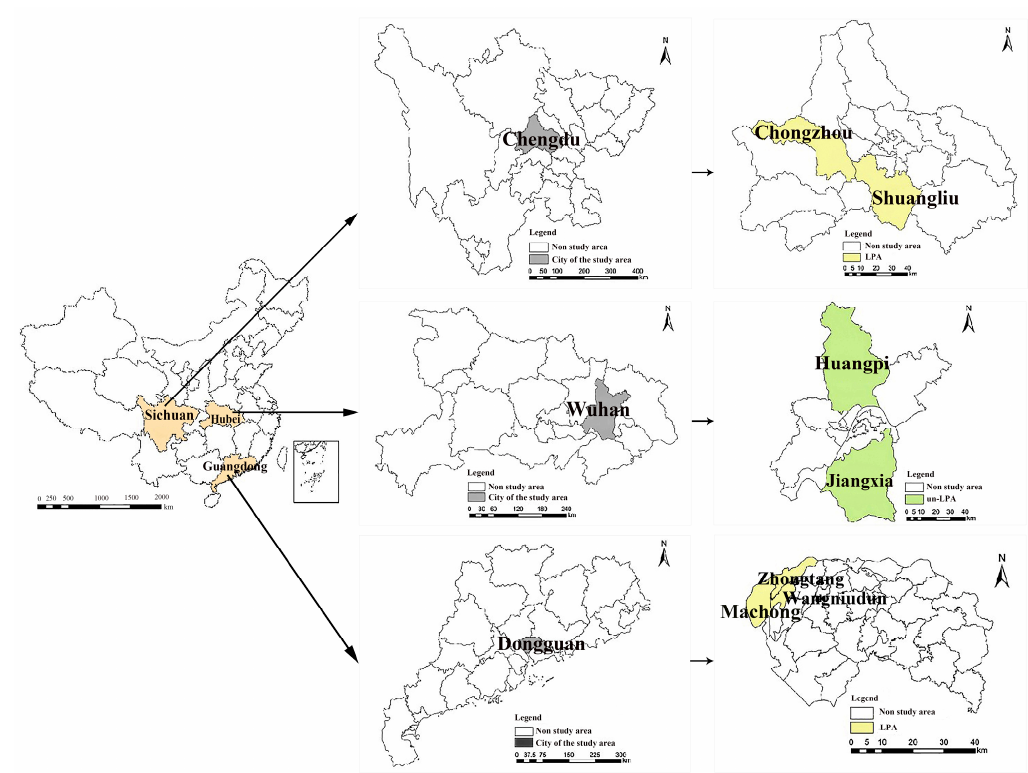
Figure 2. Location of the study areas.